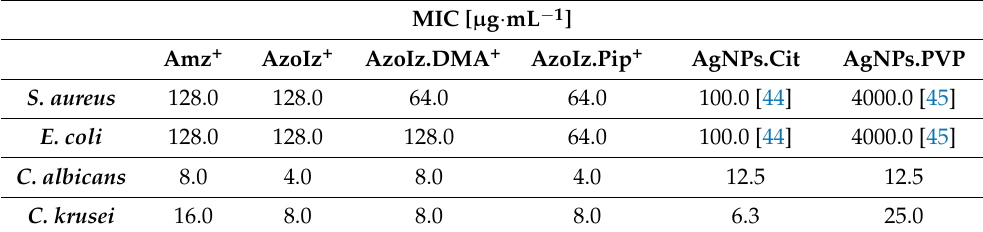
Table 2. Minimum inhibitory concentrations (MICs) of organic compounds and AgNPs that were used for calculating the fractional inhibitory concentration index (FICI), which was further applied in synergism